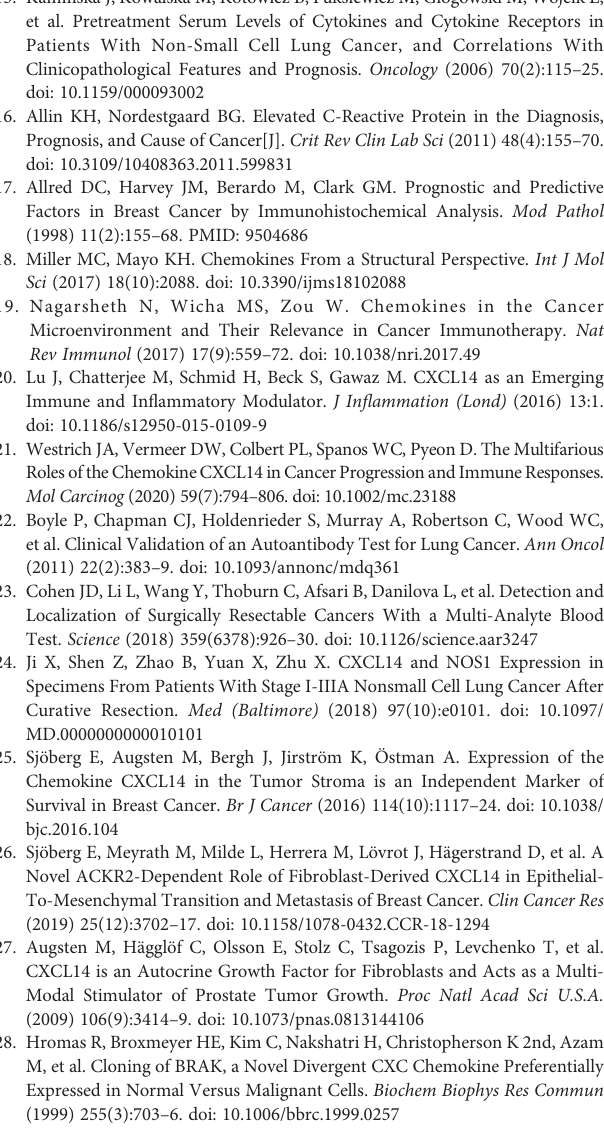
Supplementary Figure 2 | Correlation analysisofCXCL14 in plasma and urine. Pearson correlation analysis of CXCL14 in plasma and urine in 84 patients (P=0.661). Supplementary Figure 3 | (A) Comparison of the CXCL14 concentration (determined by ELISA) in plasma between benign patients (n=57) and lung cancer patients (n=286) in a retrospective cohort. P=0.209 determined by Mann – Whitney U tests. (B) ROC analysis of the diagnostic ef fi ciency of CXCL14 in benign patients versus lung cancer patients in a retrospective cohort (AUC=0.5527, 95% CI: 0.477 to